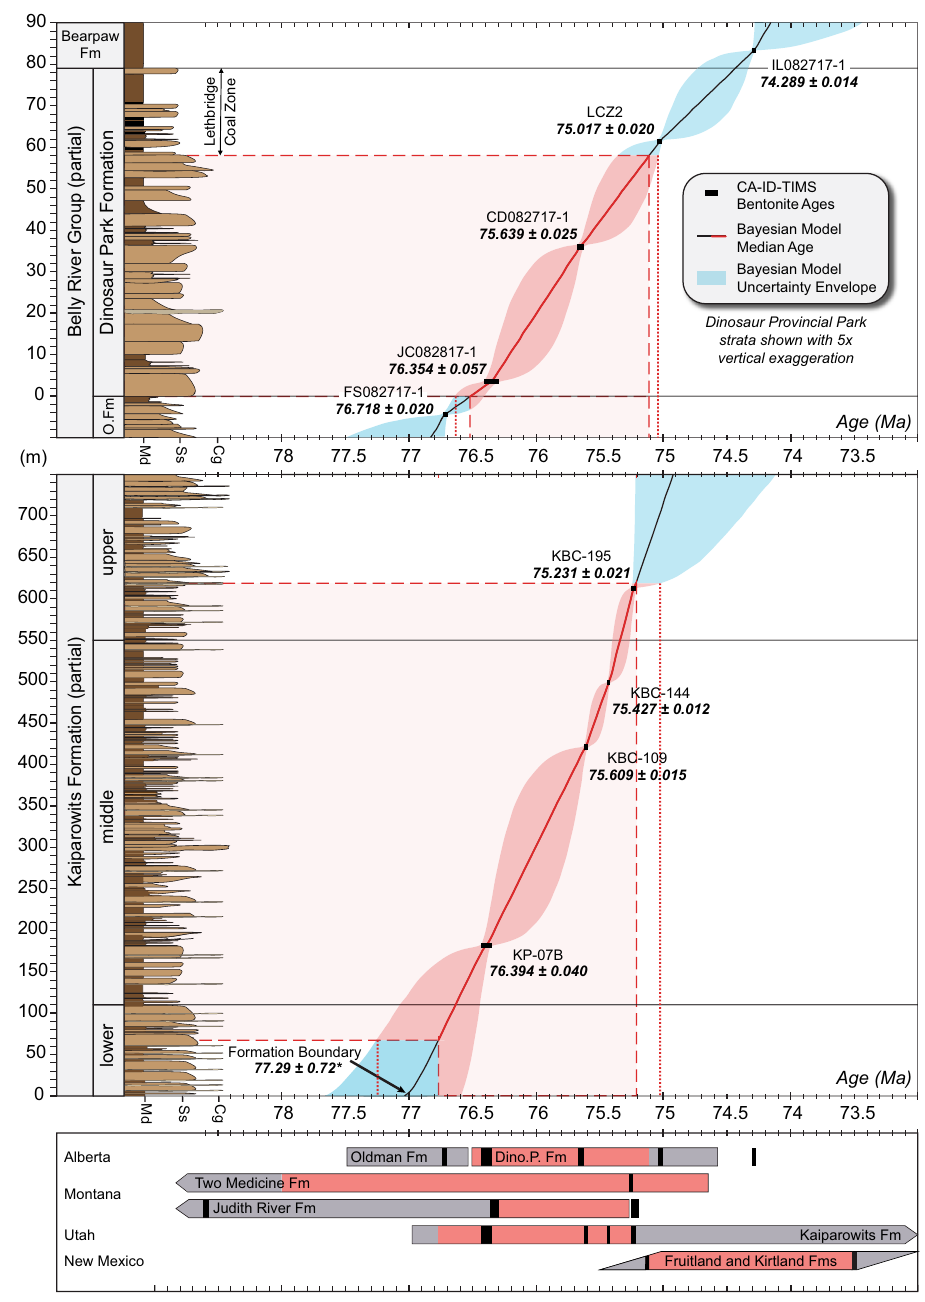
Figure 4. Lithostratigraphy, U–Pb geochronology and Bayesian age-stratigraphic models for the Dinosaur Park (top) and Kaiparowits (middle) formations. Dinosaur Park and Kaiparowits stratigraphy after Eberth and Hamblin 36 and Roberts et al. 105 , respectively. Red shading corresponds to the principal fossil-bearing intervals and their model ages, dotted lines incorporate the model age uncertainties. Bottom panel illustrates the interformational correlation of fossil intervals based on this study. * Boundary age from Beveridge et al. 86